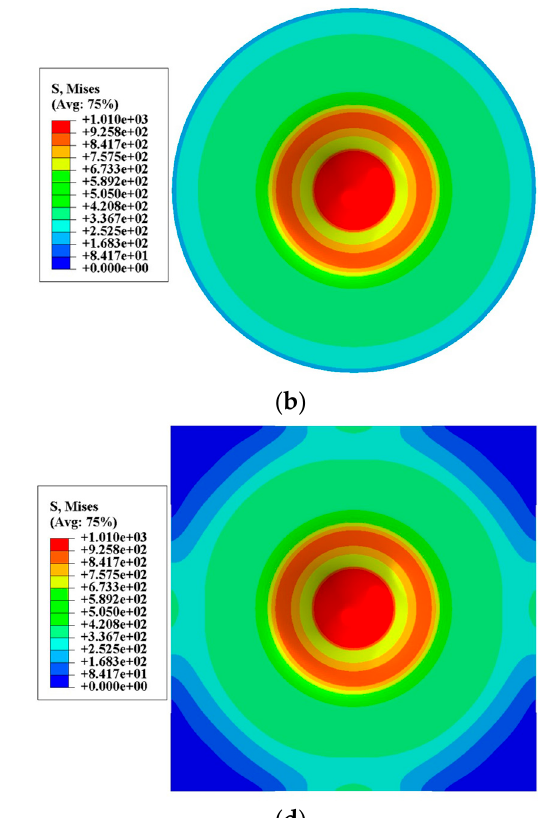
Figure 14. Force–displacement curve of SPT test for specimens in Table 7.